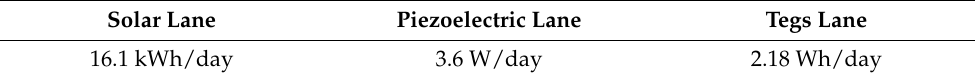
Table 7. Electric power